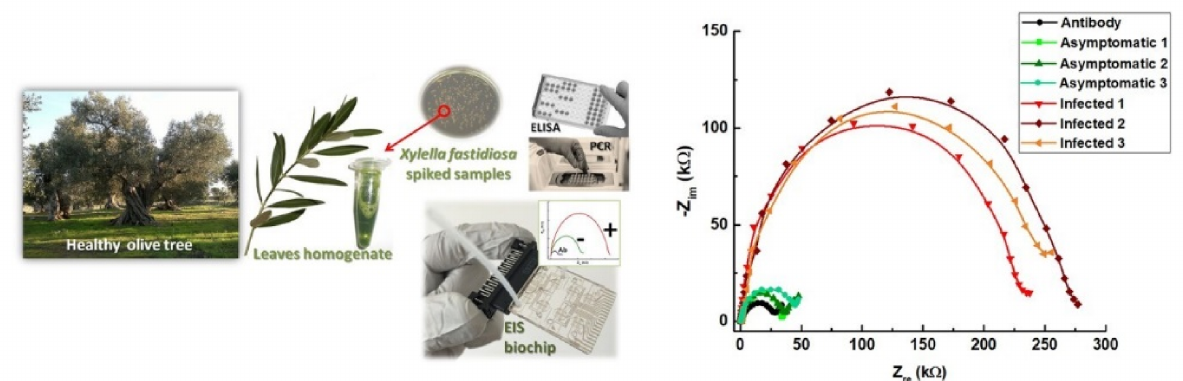
Figure 2. A LOC device for Xylella fastidiosa detection in olive trees, exhibiting large variation of EIS signals between asymptomatic trees (reporting impedance values close to the antibody baseline, around 30 k Ω ) and symptomatic infected trees (resulting in a range above 200 k Ω ) (adapted from [48]—licensed under the Creative Commons Attribution).